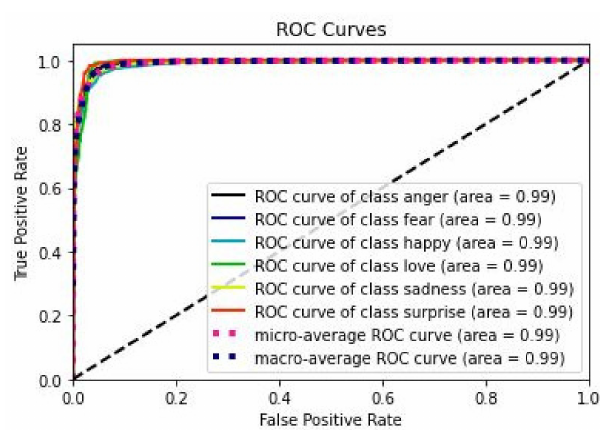
Figure 3. Logistic regression ROC—emotions classification.